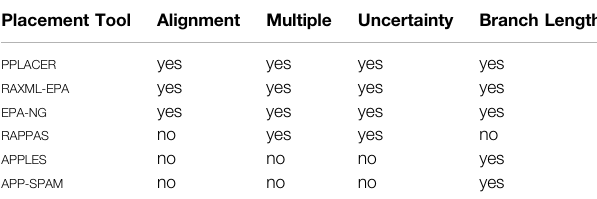
TABLE 1 | General purpose placement tools. This table compares the features of the general purpose (i.e., not use-case speci fi c) phylogenetic placement tools. Columns are as follows. Alignment: Does the tool need the QSs to be aligned against the reference alignment? Multiple: Does the tool produce multiple placement locations per QS, or just a single (best) one? Uncertainty: Is there some measure of uncertainty (such as LWR) assigned to each placement location? Branch Length: Does the tool compute the involved branch lengths at each placement location for each